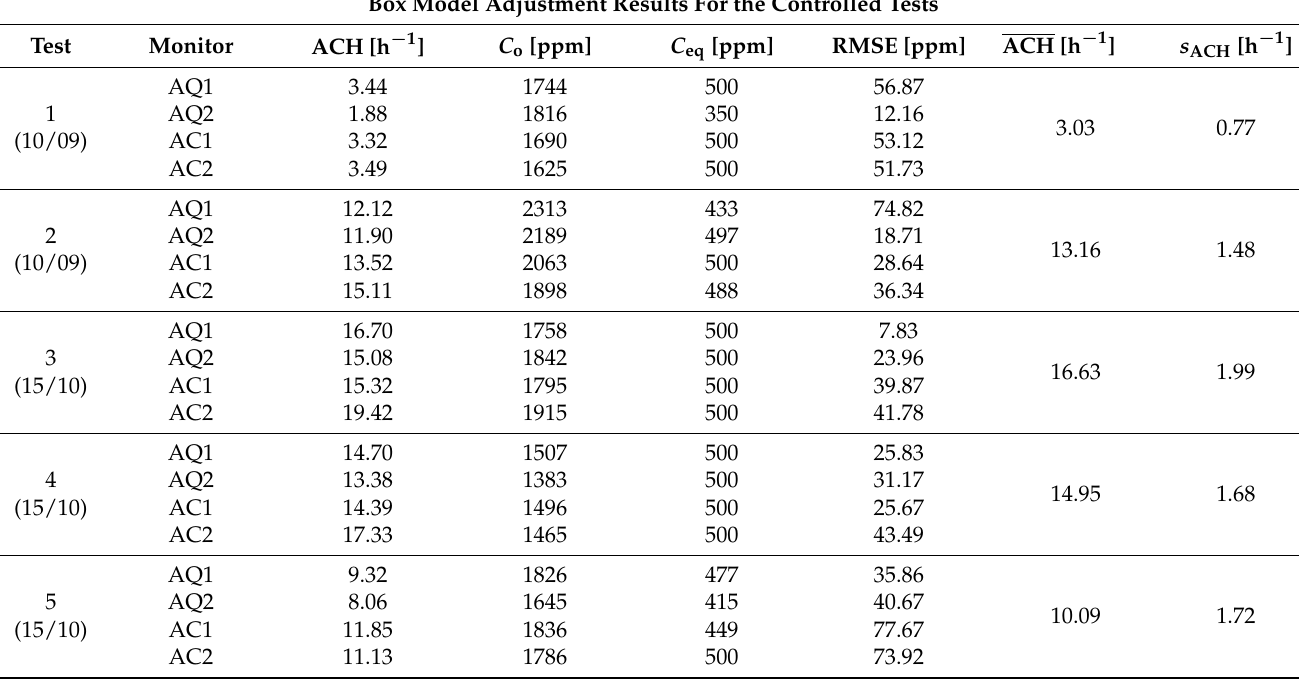
Table 2. Adjustment results for the box model parameters for each test and monitor. Box Model Adjustment Results For the Controlled Tests